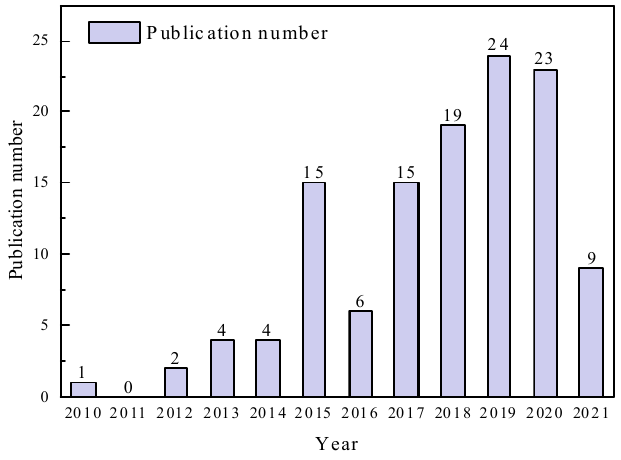
Figure 1. Timeline of publications from 2010 to 2021.